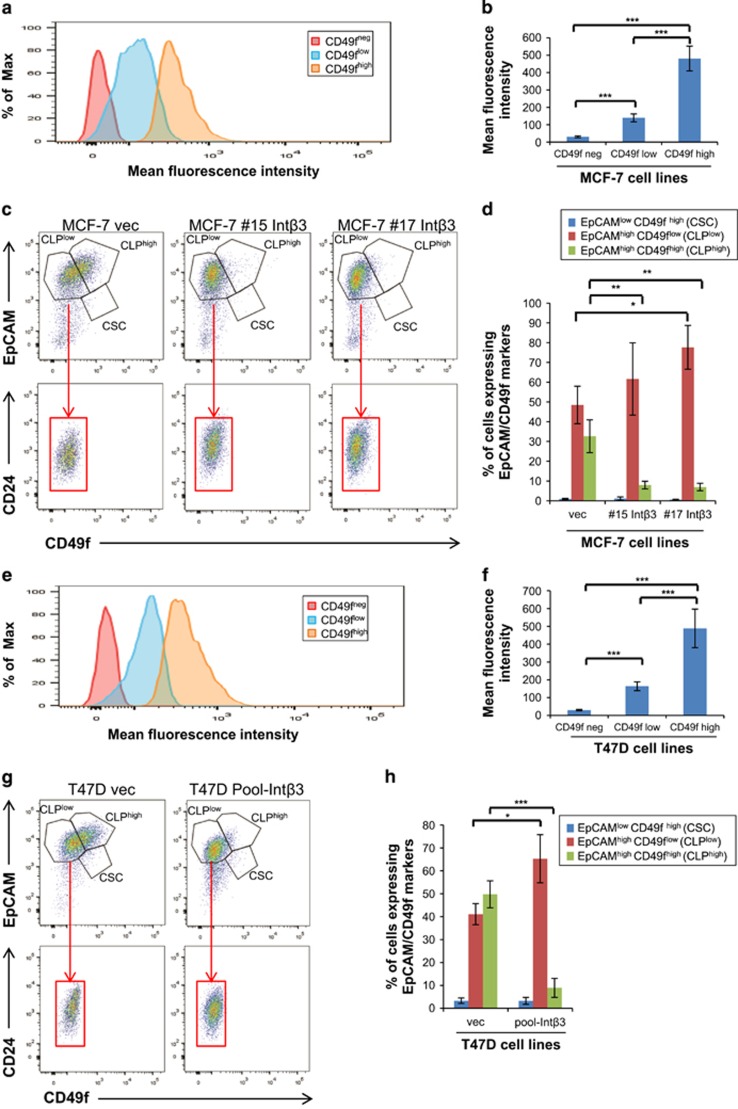
Int-αvβ3 expression in MCF-7 and T47D cells promotes the enrichment of EpCAMhighCD49flowCD24+ subpopulation of cells. Cells derived from second generation of grown mammopsheres of either (a–d) MCF-7 cell lines, or (e–h) T47D cell lines. (a and e) Histogram representing three cell populations with different levels of expression of CD49f normalized to unstained cells. (b and f) Mean fluorescence intensity of CD49f expression in the different subpopulations. (c and g) Top panel: representative dot plot showing CSC expressing EpCAMlowCD49fhigh, CLPs either expressing EpCAMhighCD49flow (CLPlow) or EpCAMhighCD49fhigh (CLPhigh) phenotype. Bottom panel (red square): representative dot plot showing CLPlow subpopulation positive for CD24 expression. (d and h) Percentage of CSC, CLPlow and CLPhigh. Quantification was carried out with FACSdiva software. Columns; mean, bars; STD; n=3; *P⩽0.05, **P⩽0.01 ***P⩽0.001